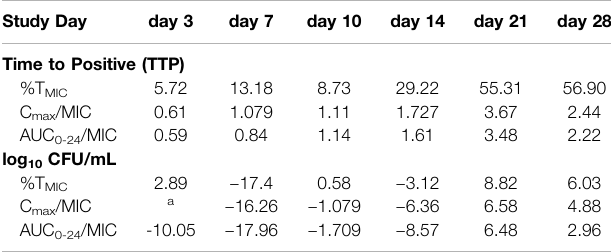
TABLE 2 | Determination of the pharmacokinetic/pharmacodynamic index associated with cefdinir M. tuberculosis kill in the HFS-TB. The table show the AICscoreforbothTTPandCFUreadouts.TheAUC 0 – 24 /MICconsistentlyshowed lowest AIC score at each sampling time-point, therefore, selected as the PK/PD index linked to cefdinir ef fi cacy in the